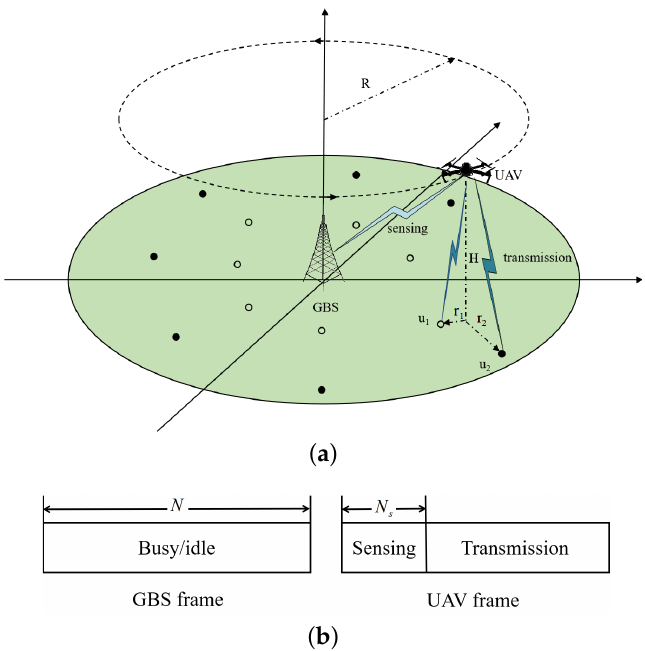
Figure 1. ( a ) Illustration of a NOMA-based cognitive UAV short-packet communication system. ( b ) GBS and UAV frame